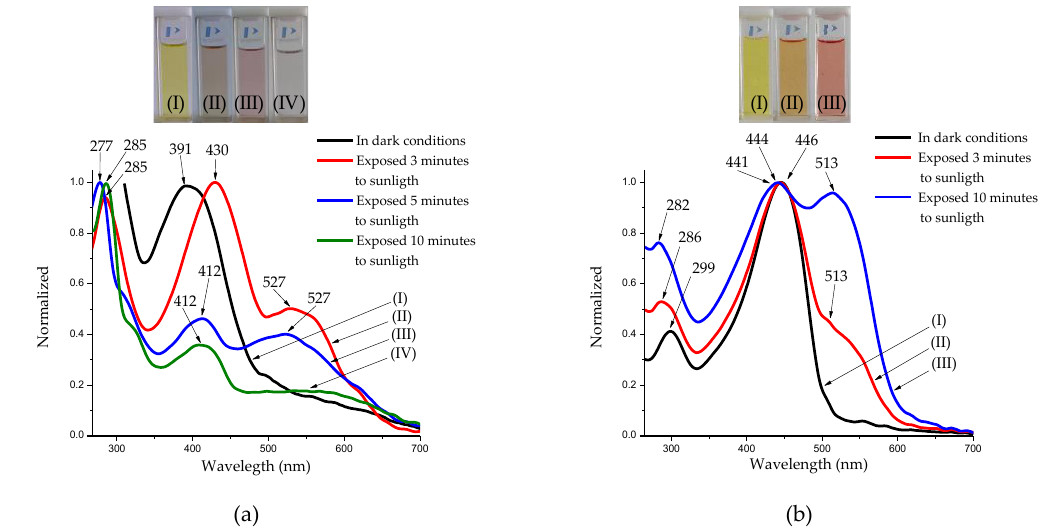
Figure 5. Absorption spectrum: ( a ) DAFCHO and ( b ) FDACHO in chloroform under dark conditions without irradiation (black line) and photochromic effect with irradiation of sunlight (red line, blue line and green line) at room temperature.